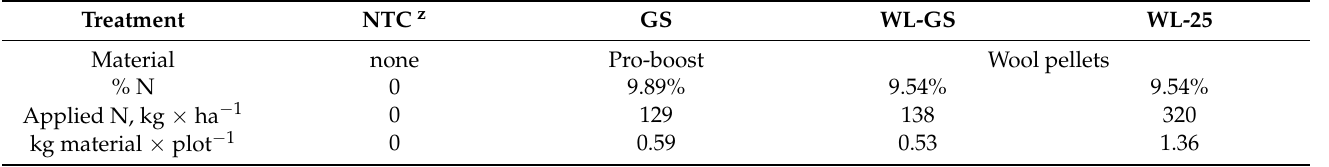
Table 2. Experimental fertilizer treatments applied to tomato and spinach plots at two locations. Each 1.2 m × 3.3 m plot totaled ~0.0004 ha in